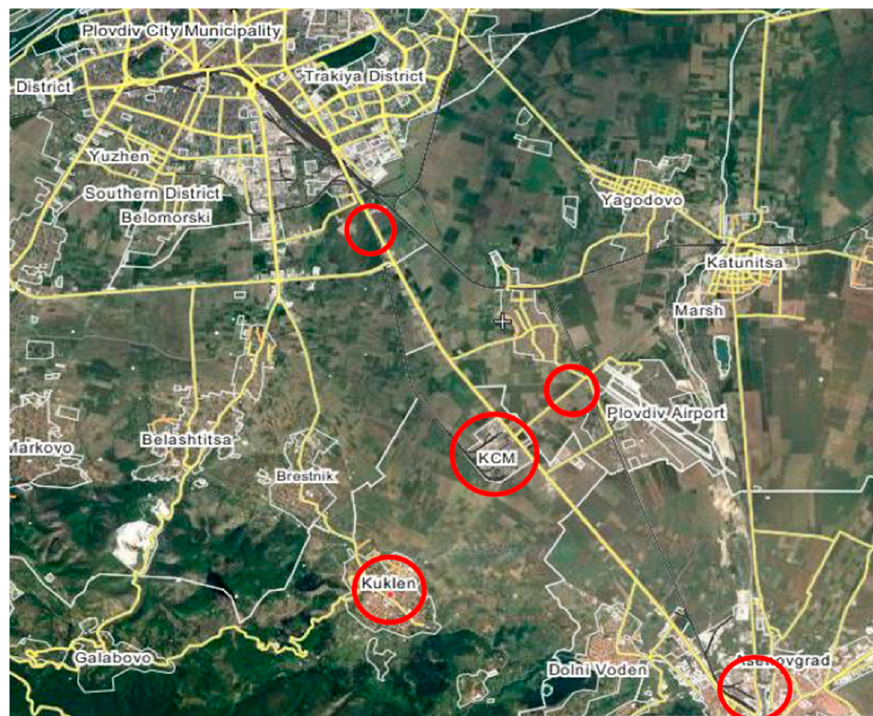
Figure 1. Sampling locations.